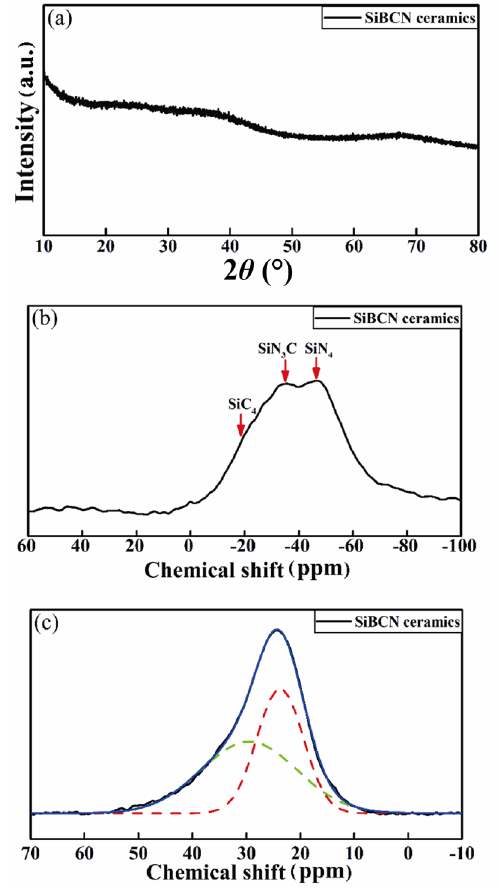
Fig. 6 (a) XRD pattern, (b) 29 Si MAS NMR spectrum, and (c) 11 B MAS NMR spectra of SiBCN ceramics pyrolyzed at 1100 . ℃